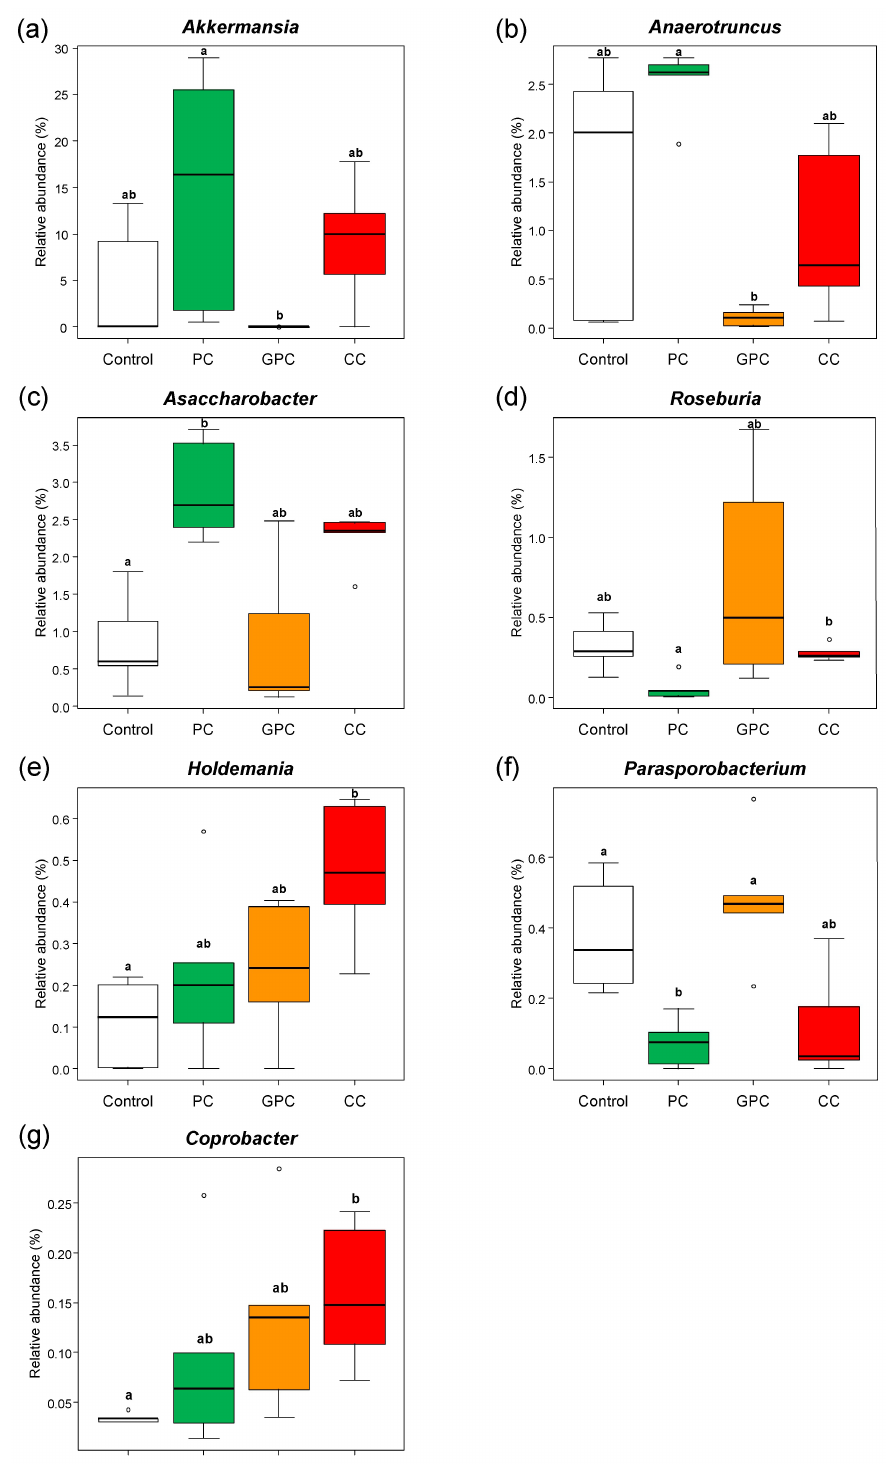
Figure 5. Effects of dietary choline compounds on relative abundances of fecal microbiota at the genus level. ( a – g ) Relative abundances of Akkermansia , Asaccharobacter , Anaerotruncus , Roseburia , Holdemania , Parasporobacterium , and Coprobacter , respectively. Data are represented as box plots with outliers (shown as white circles) ( n = 5 per group). a,b Different letters show significant difference at p < 0.05 using the Kruskal–Wallis test, followed by Steel–Dwass multiple comparison post hoc